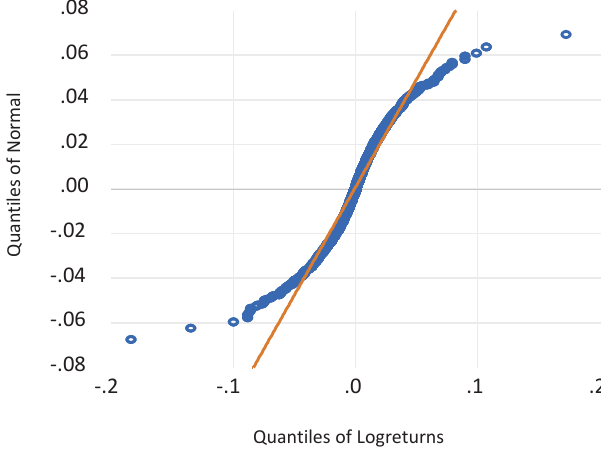
Source: Computed using EViews.